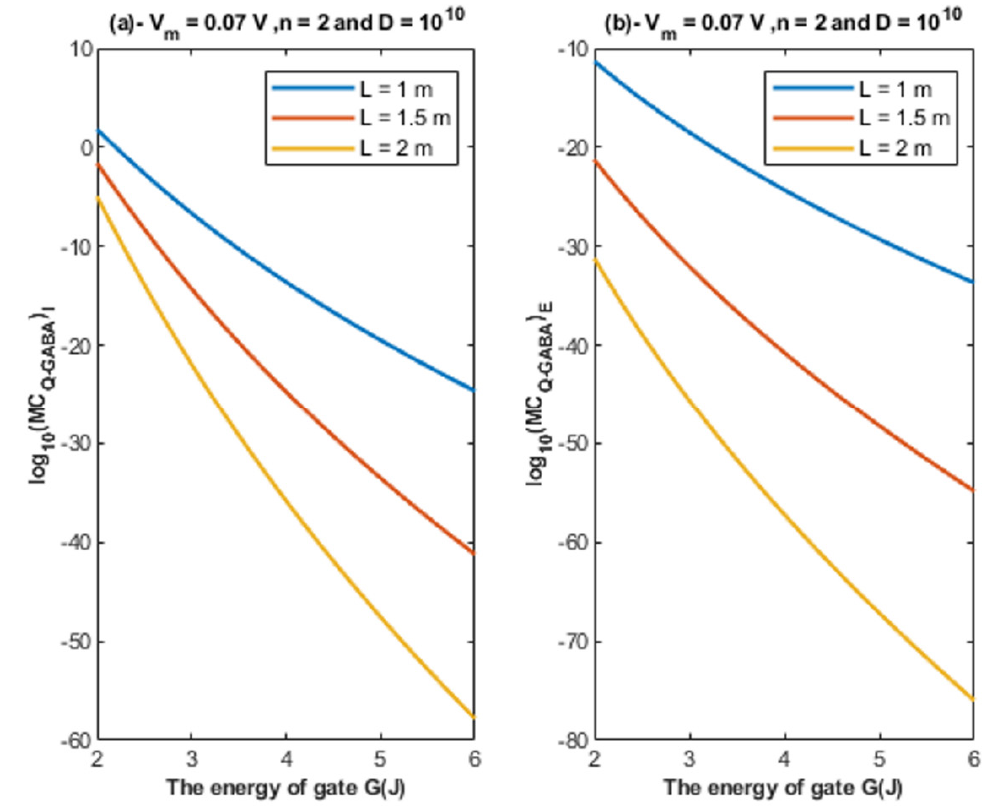
Figure 10. ( a , b ): The figure represents the relationship between the energy of the gate and the common logarithm of the quantum membrane conductance of the intracellular chloride ions log ( ) MC − and the quantum membrane conductance of the extracellular chloride ions 10 Q GABA I log ( ) MC − , respectively. The relationships are investigated at different values of gate 10 Q GABA E length and according to the setting values above each graph.